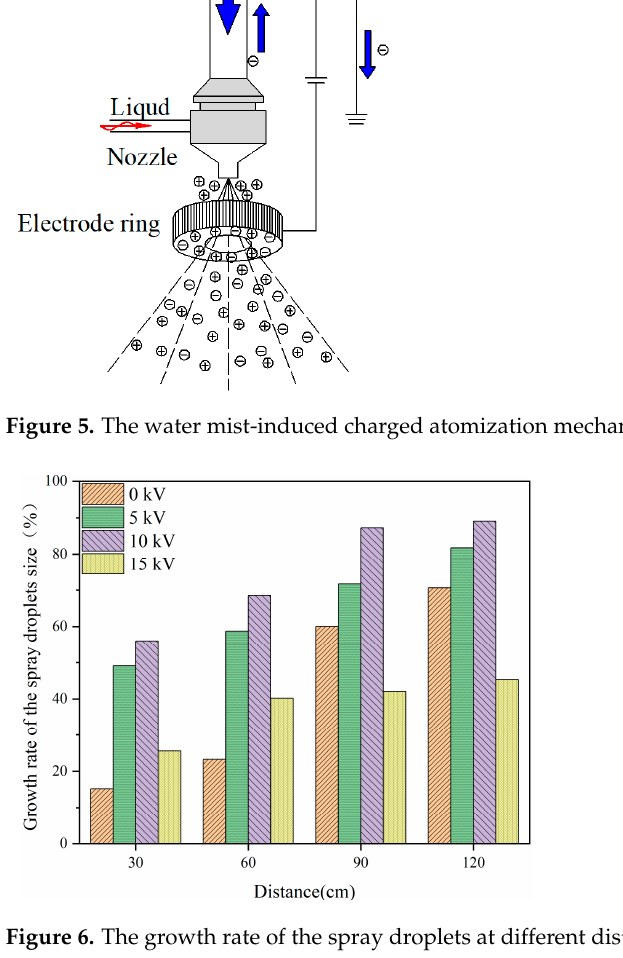
Figure 6. The growth rate of the spray droplets at di ff erent distances and charging voltages.